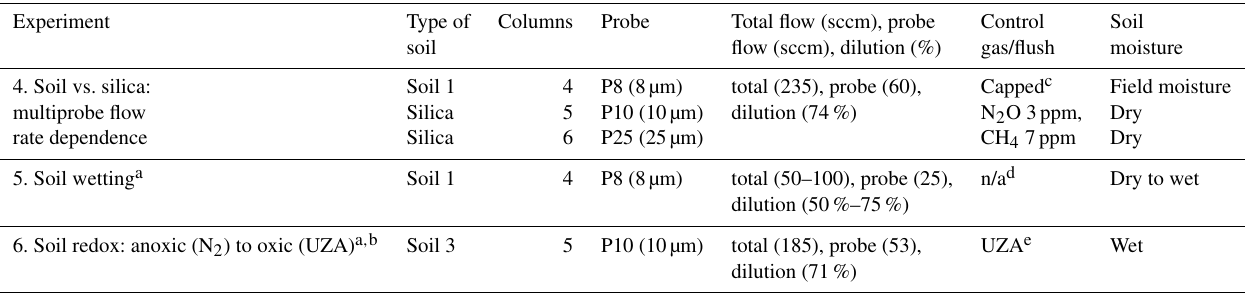
Table 4. Experiments under controlled conditions with the soil and silica matrix using System 2.